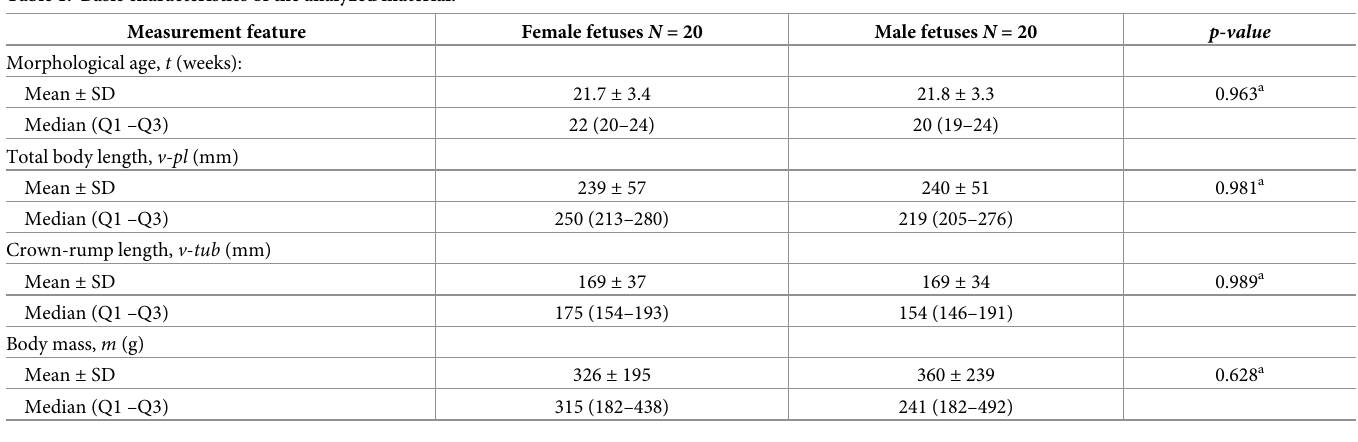
Table 1. Basic characteristics of the analyzed